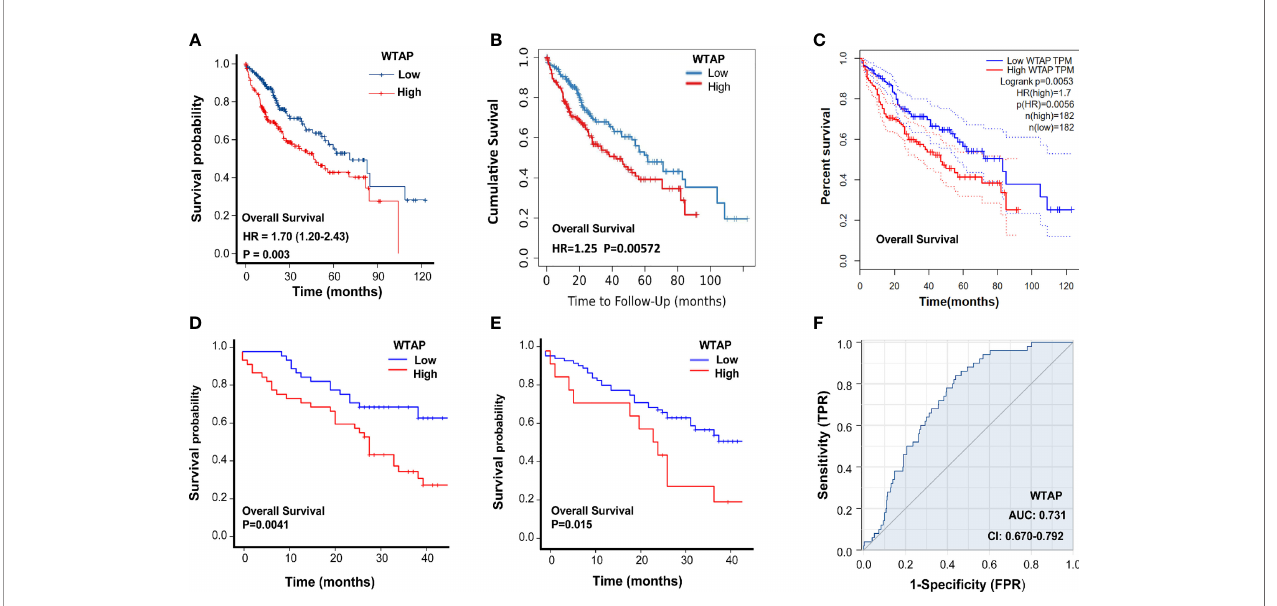
FIGURE 2 | Association between WTAP expression and HCC prognosis. (A-C) Overall survival of patients in the WTAP high- and low-expression groups in TCGA, TIMER2.0, and GPEIA. (D) Overall survival of HCC patients with WTAP high- and low-expression in the cytoplasm analyzed using clinical information of tissue microarrays. (E) Overall survival of HCC patients with WTAP high- and low-expression in the nucleus analyzed using clinical information of tissue microarrays. (F) Area under the curve value of the risk signature to predict the overall survival of patients with HCC.